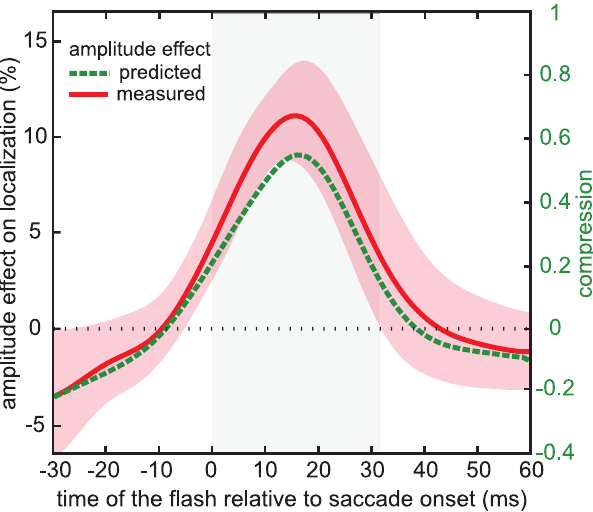
Figure 7. How localization depends on the endpoint of the saccade. The red curve shows the average difference between flash localization for saccades to dots that are 10% nearer and further than the equivalent shaft length, expressed as a percentage of the equivalent shaft length (left axis). The green curve shows the effect predicted from the compression at each time of the flash and the difference in saccade amplitude. Further details as in Figure 5. Note that for a compression of 1, the predicted average difference in localization would now be 16%, because the saccade amplitudes differed by 16%.